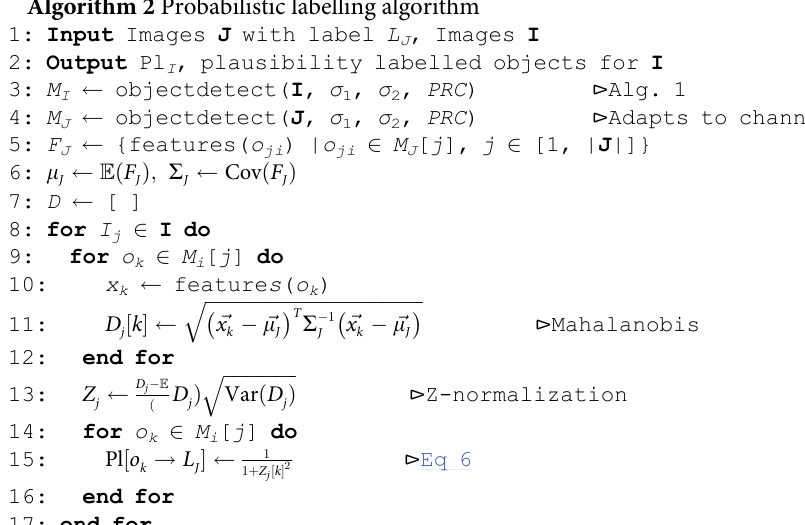
Algorithm 2 Probabilistic labelling